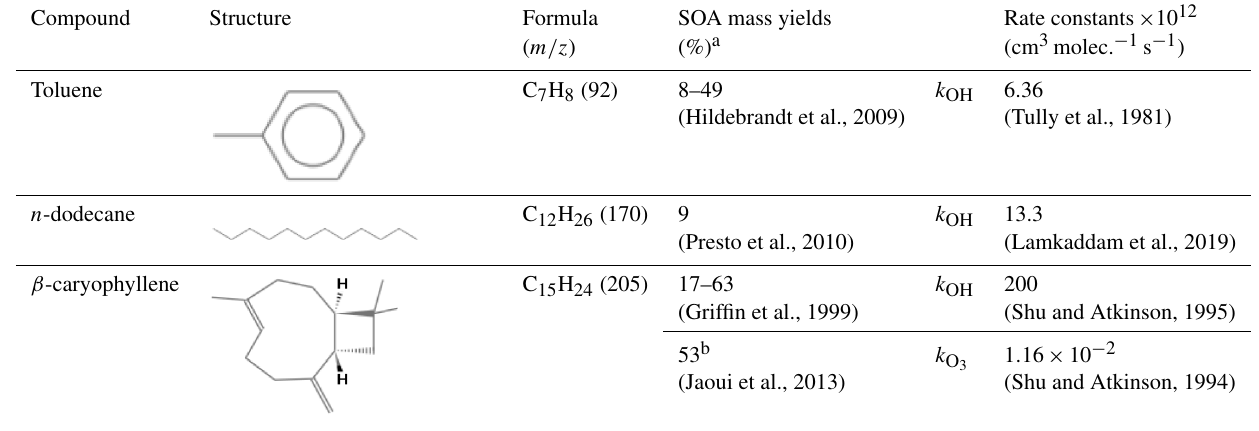
Table B1. Organic compounds engaged in this study. The parameters are taken from room temperature data.